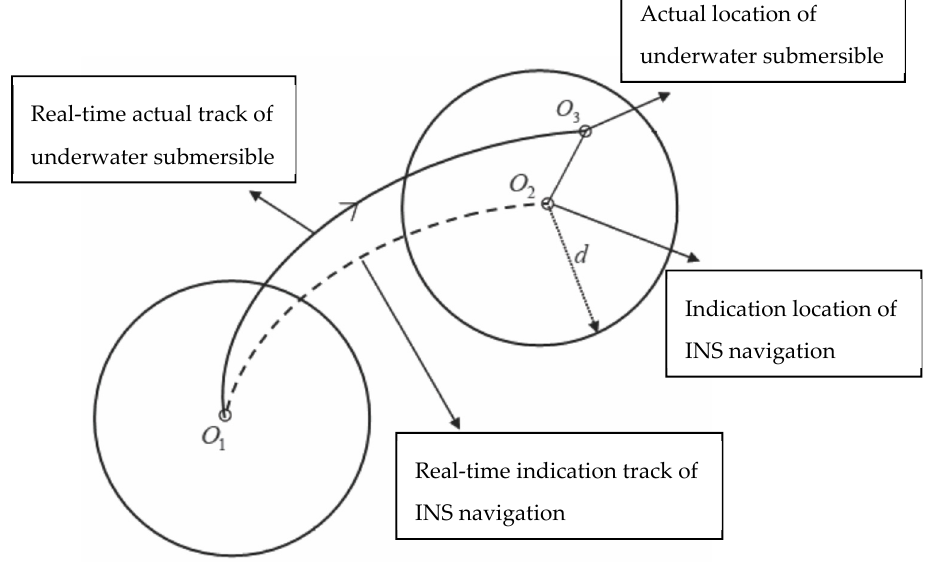
Figure 1. Comparison between actual location of underwater submersible and INS navigation location.